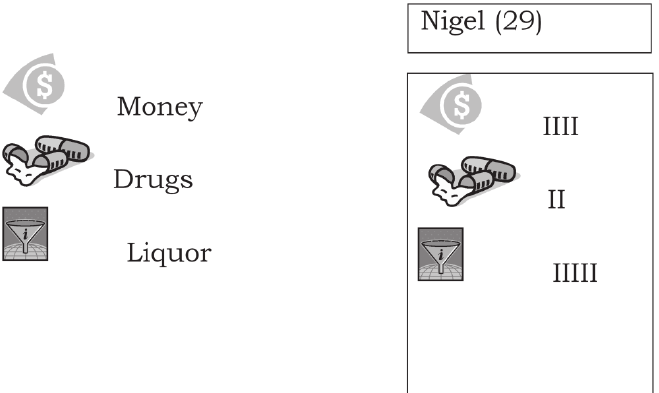
Figure 3. A visual representation of the dominant stories involved in Nigel Ford’s